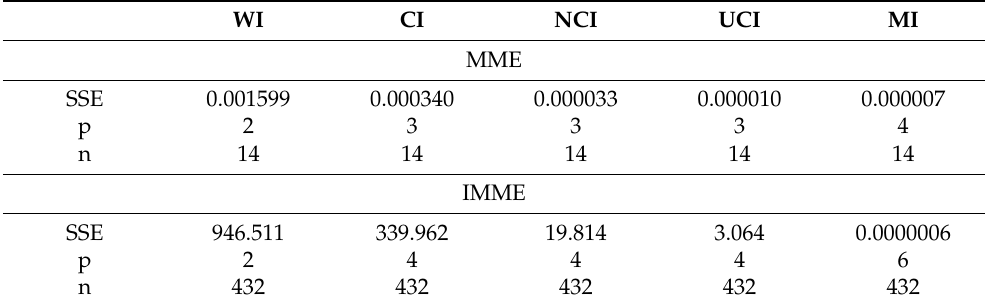
Table 3. Sum of square error (SSE) values for different models obtained by the MME and IMME methodologies.